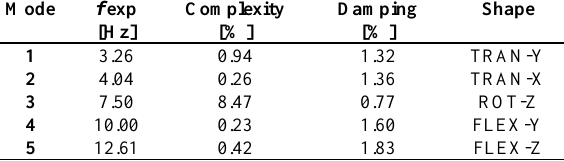
Table 1 Experimental dynamic parameters of San Ciriaco